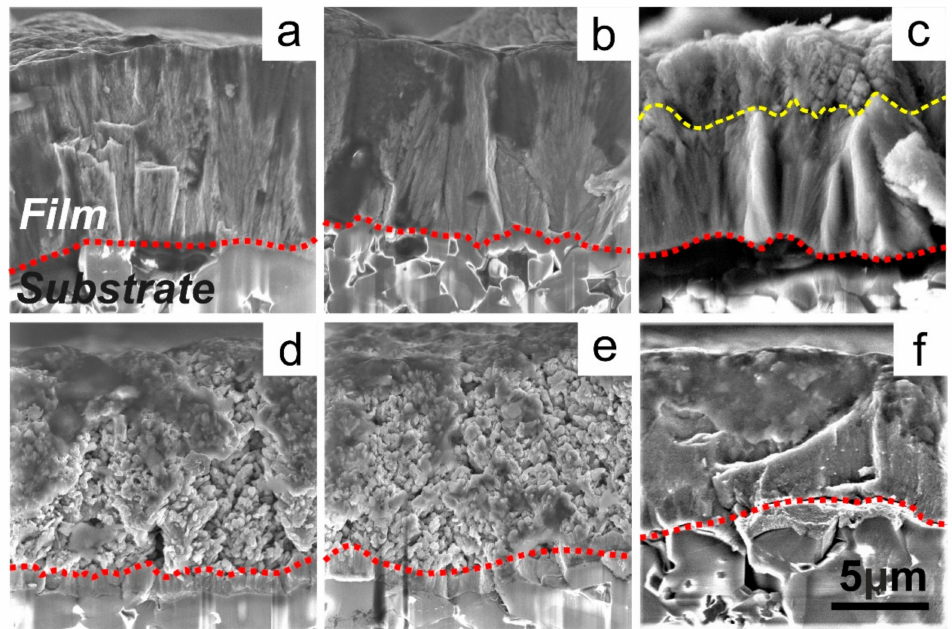
Figure 1. Cross-section images of Hf–Al–C films deposited at the various Al target discharge: 1 A ( a ), 2 A ( b ), 3 A ( c ), 4 A ( d ), 5 A ( e ), and reference HfC film ( f ).